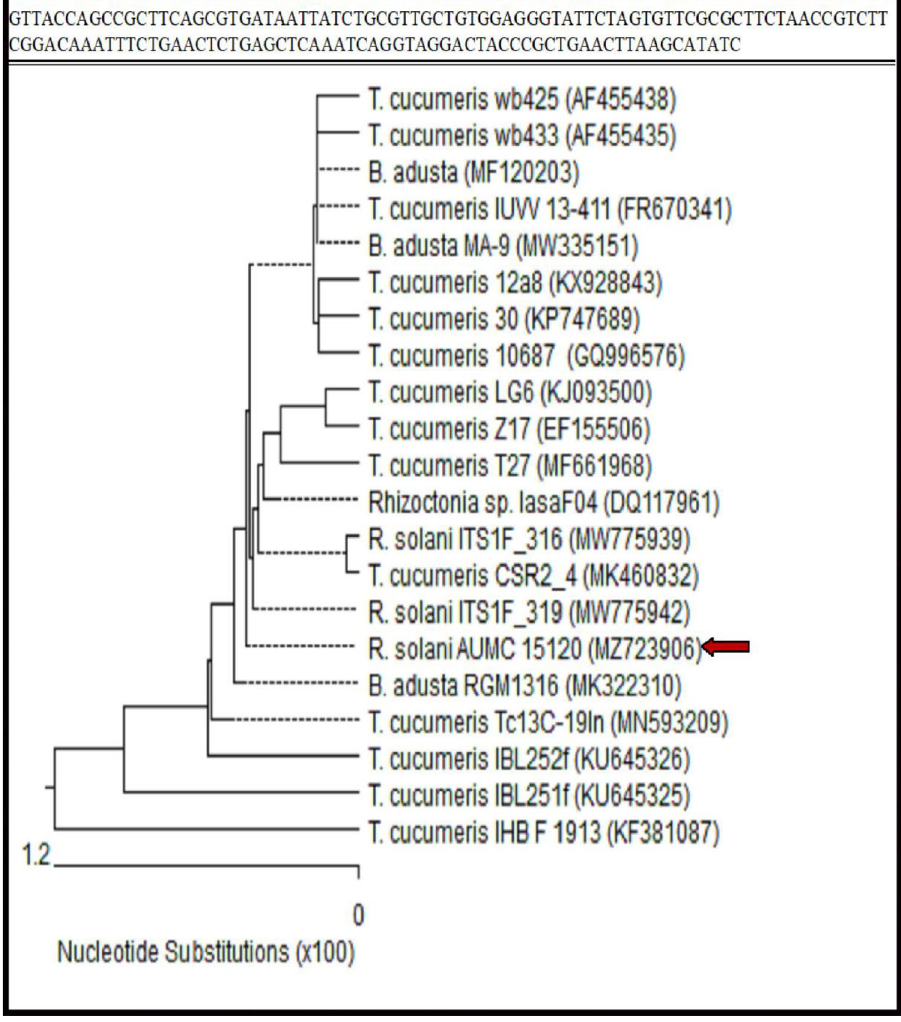
Figure 5. Phylogenetic tree based on ITS sequences of rDNA of the fungal strain isolated in the present study ( Rhizoctonia solani AUMC 15,120) aligned with closely related sequences accessed from the GenBank, (R. = Rhizoctonia , T. = Thanatephorus and B. = Bjerkandera ), (https:// www. ncbi. nlm. nih. gov/ nucco re/ gb: MZ723 906).